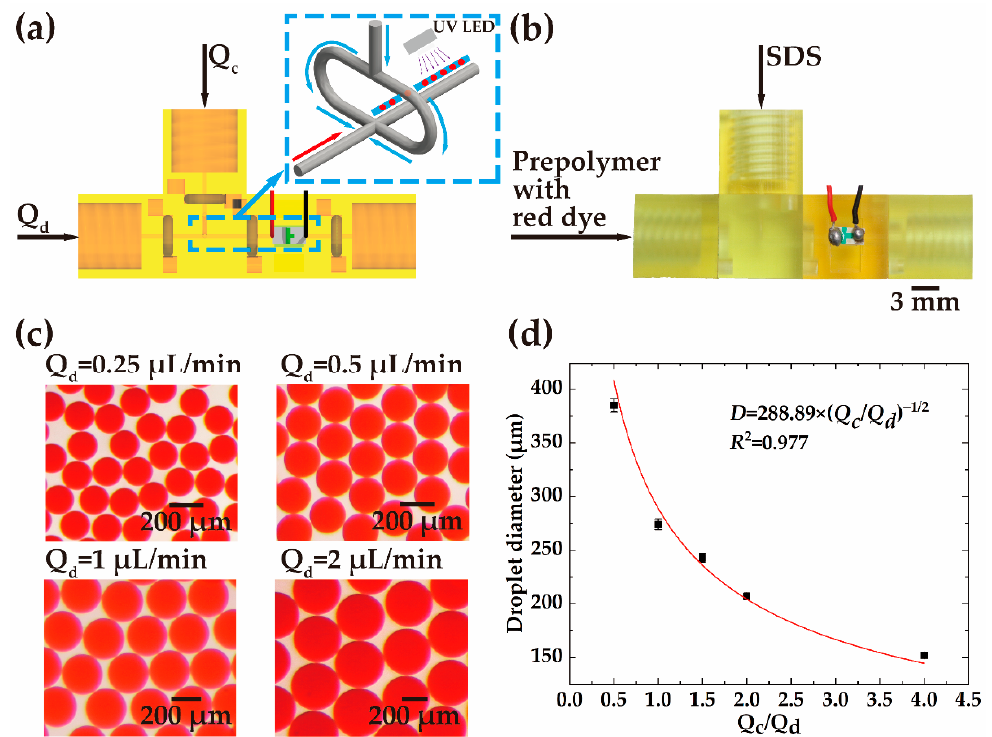
Figure 4. Schematic illustration of generation and UV curing of single droplets. ( a ) Schematic drawing and ( b ) the experimental setup of the assembled system for single-droplet generation and curing. ( c ) The photopolymerized single droplets generated at different flow rates of the discrete phase and the fixed flow rate (1 μ L/min) of the continuous phase. ( d ) The plot of the flow rate ratio ( Q c / Q d ) versus the droplet diameter at different flow rates.